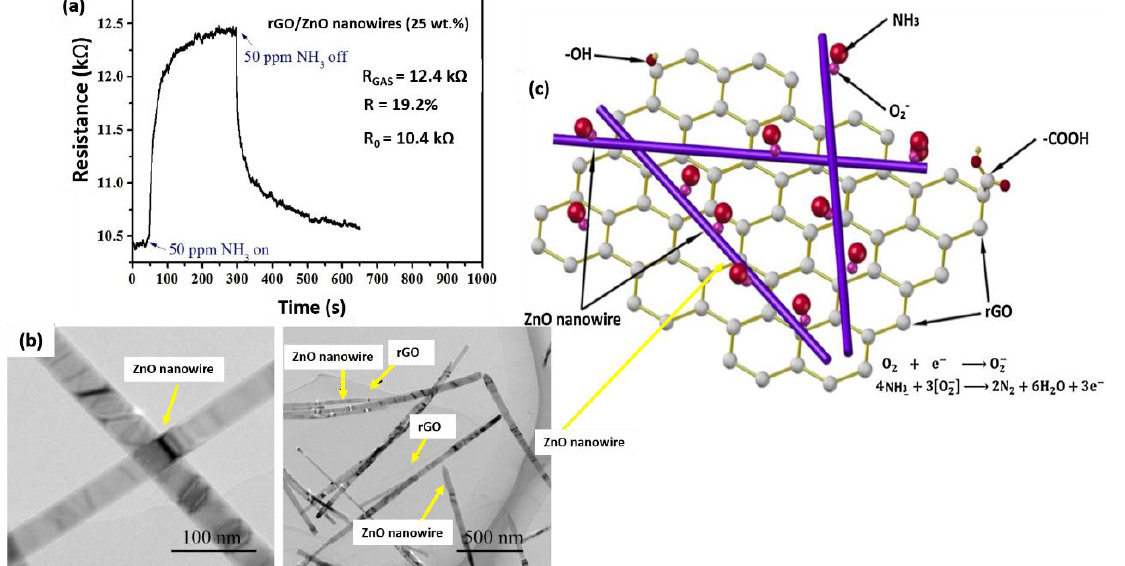
Figure 11. ( a ) The response curve of rGO/ZnO nanowires when exposed to 50 ppm NH 3 at room temperature, ( b ) TEM image of rGO/ZnO nanowire nanocomposite, and ( c ) the sensing mechanism of rGO/ZnO nanowires towards NH 3 detection. Reproduced from ref. [163].